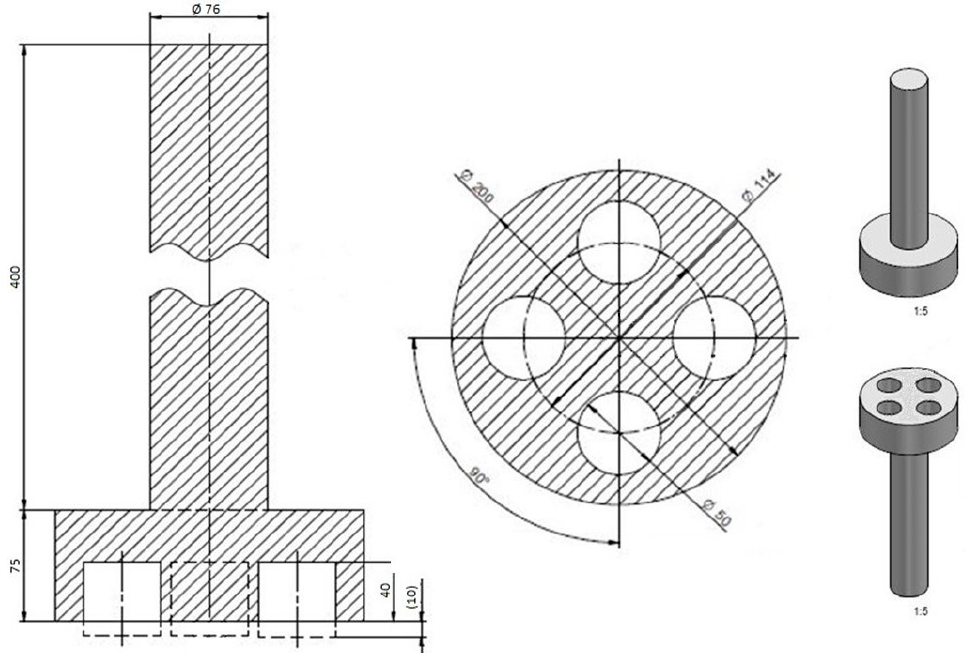
Figure 2. Schematic of the test casting model